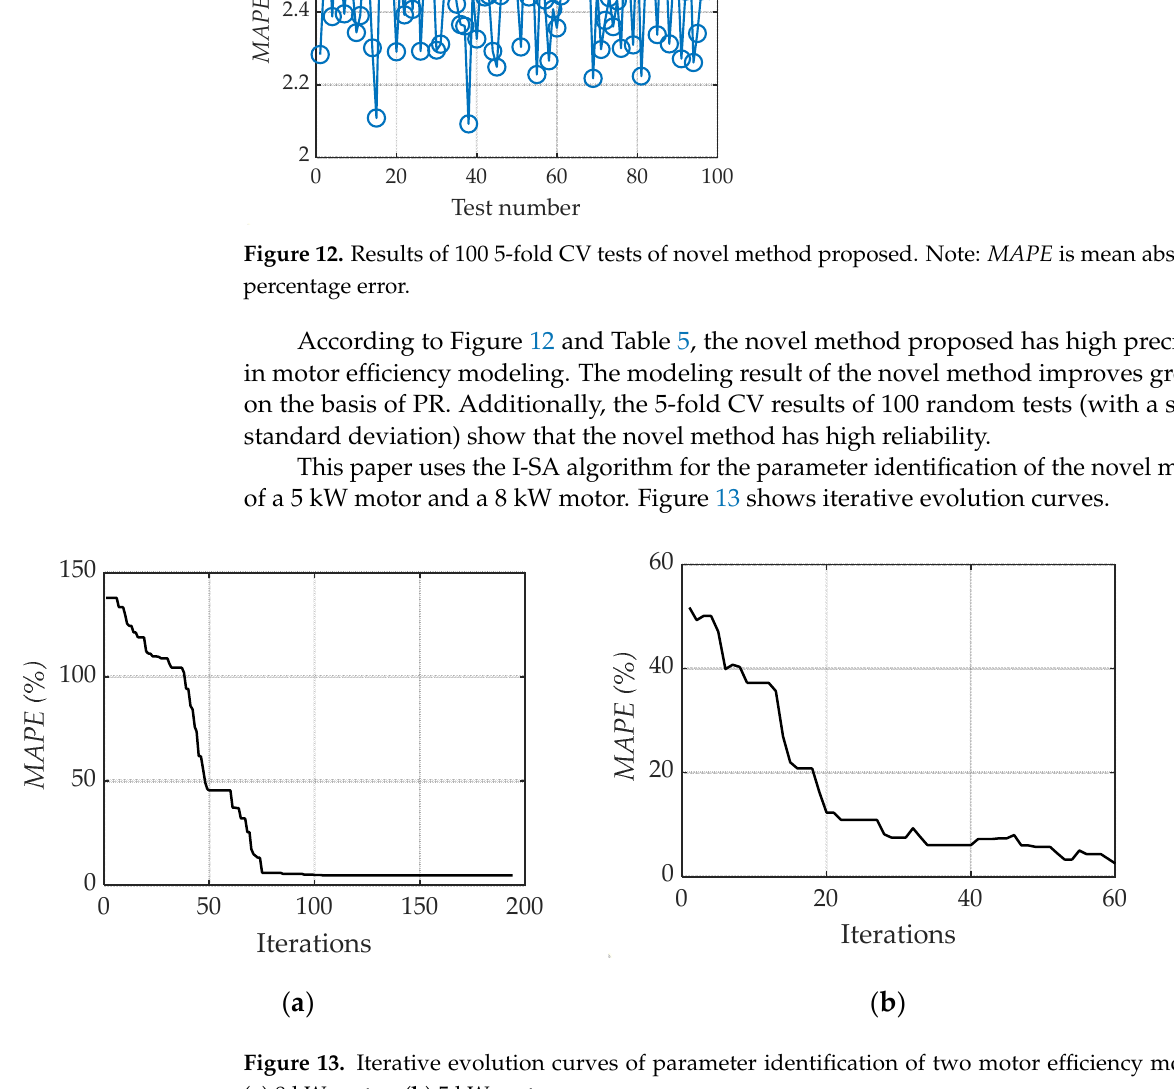
( b ) Figure 14. Efficiency models of two motors in full working conditions. ( a ) 8 kW motor; ( b ) 5 kW motor. Figure 14 shows that the motor efficiency models built with the novel method have ideal estimation results in the full working conditions of the motor speed m n and the motor torque